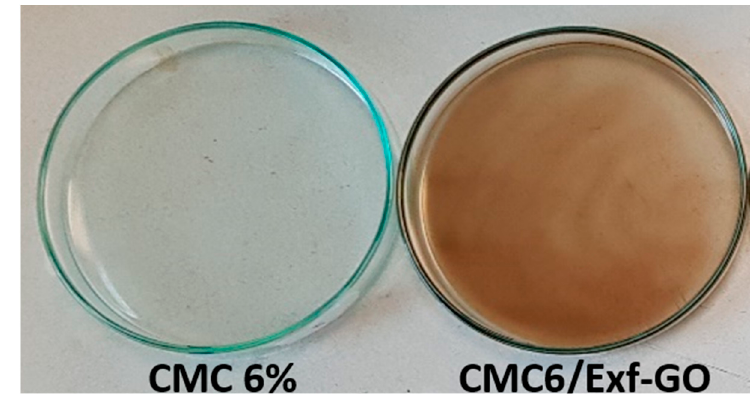
Figure 1. Photo of the CMC 6% film and CMC6/ Exf -GO nanocomposite in Petri dishes.